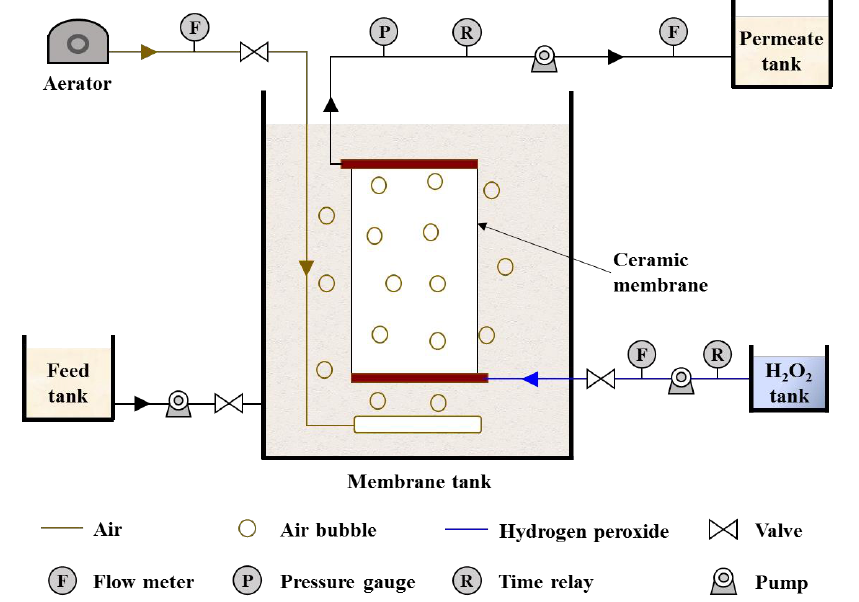
Figure 1. Schematic diagram of experimental